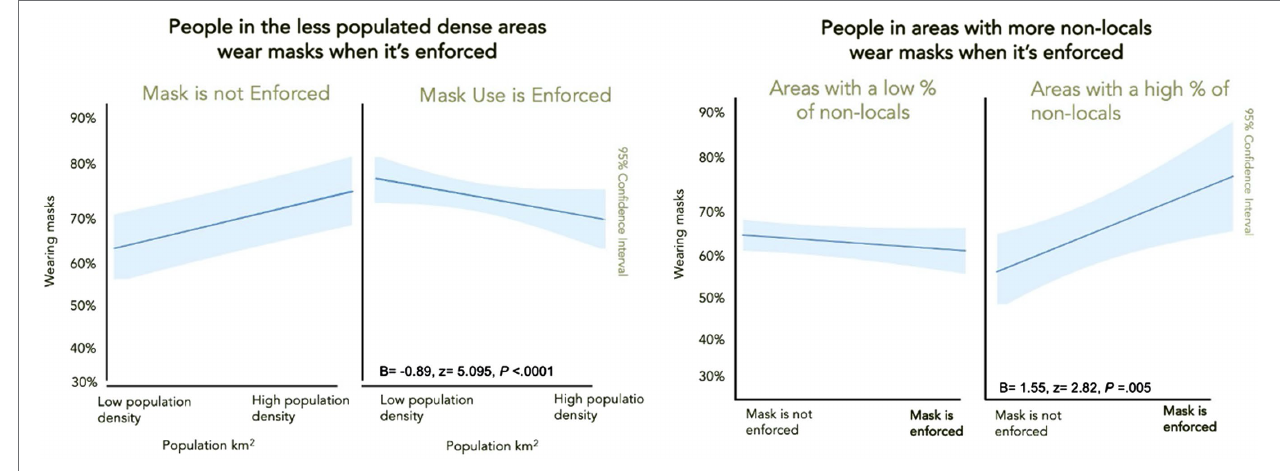
FIGURE 4 | Mask enforcement mattered less in populated dense areas and people complied more in areas with less population density (left) . People wear masks more in areas with more outgroup members (right)